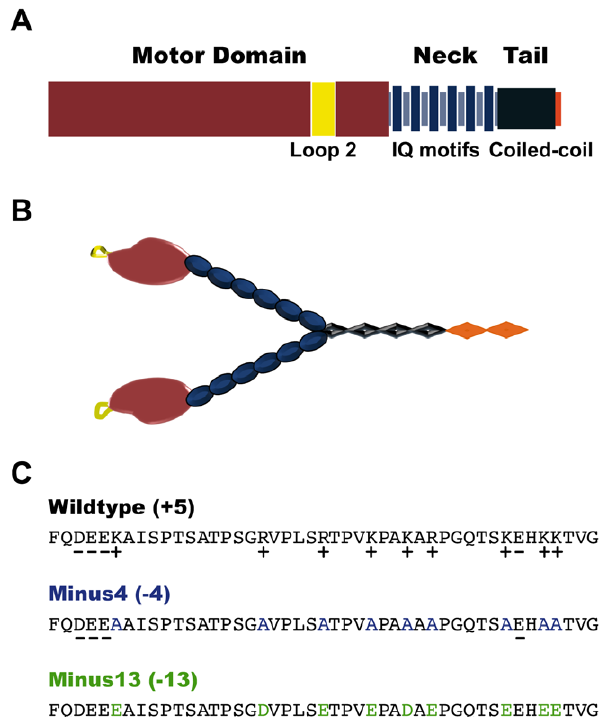
Figure 1. Schematic representations of the myosin V loop 2 constructs. (A) Schematic diagram depicting the domain structure of myo V with its surface-exposed loop 2 shown in yellow. The C-terminal GCN4 motif ensures dimerization. (B) Schematic domain model of truncated myo V in its homodimeric form. The regions are color-coded for each structural motif. The same set of colors is used in A and B. (C) Comparison of the loop 2 sequences from myo V Wildtype , Minus4 and Minus13 . Mutants Minus4 (blue) and Minus13 (green) were designed by altering positively charged amino acids (lysines and arginines) to alanine and glutamic/aspartic acid, respectively. ( + ) and ( 2 ) indicate positively and negatively charged amino acids, respectively. The net charge of each construct is indicated in brackets next to the respective construct.